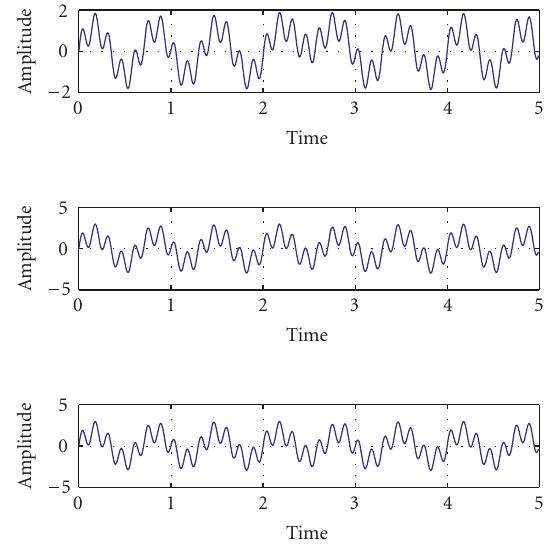
Figure 4: The mixtures obtained by mixing the sources of Figure 3 using a random mixing